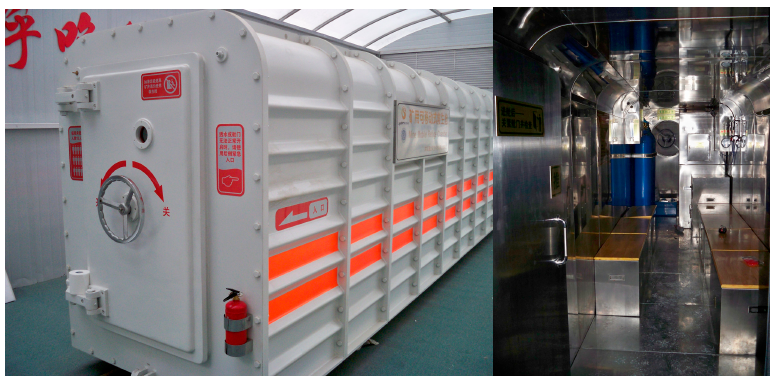
Figure 1. Appearance and internal map of the coal mine emergency refuge system.